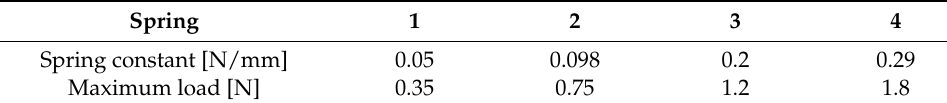
Table 4. Spring constant and maximum load for tested springs.